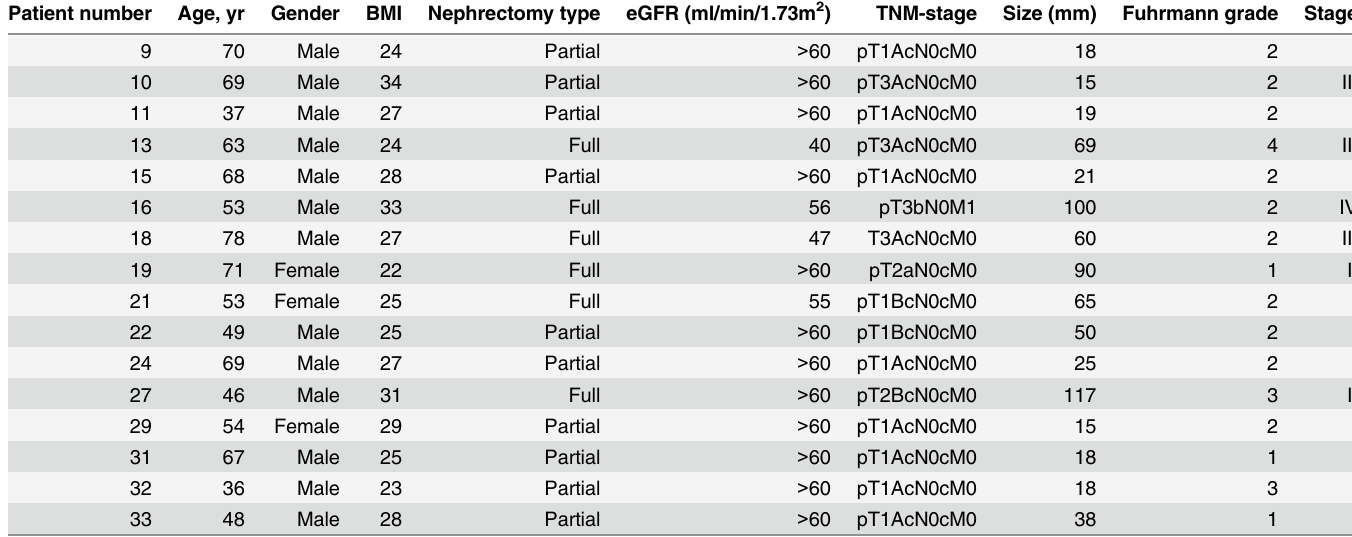
Table 1. Characteristic patient features at the time of surgery. eGFR was calculated with the MDRD formula. The staging was performed based on the EAU Guidelines on renal cell carcinoma: 2014 update